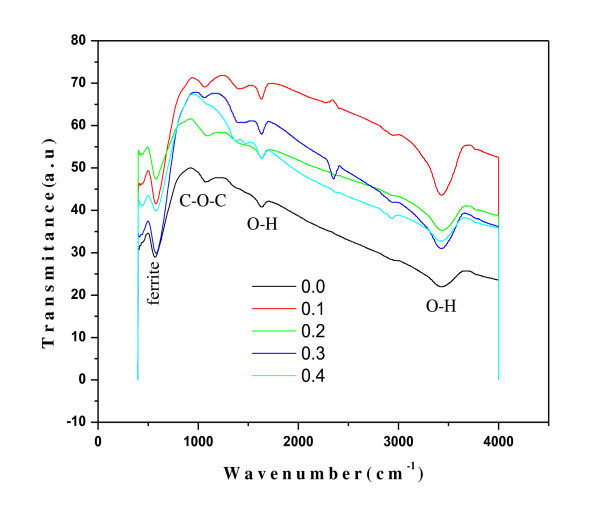
FTIR spectra of Ni0.2Cd0.3Fe2.5 - xAlxO4 (0.0 ≤ x ≤ 0.5) ferrite nanoparticles.